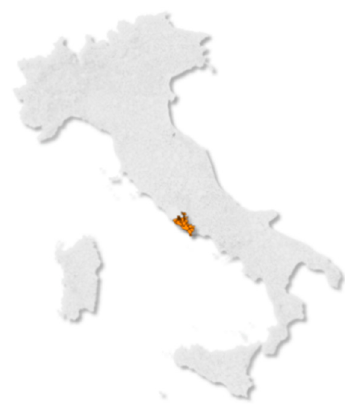
Figure 1. The production area of the Agro Pontino Kiwifruit netchain (orange area) compared to Italy.